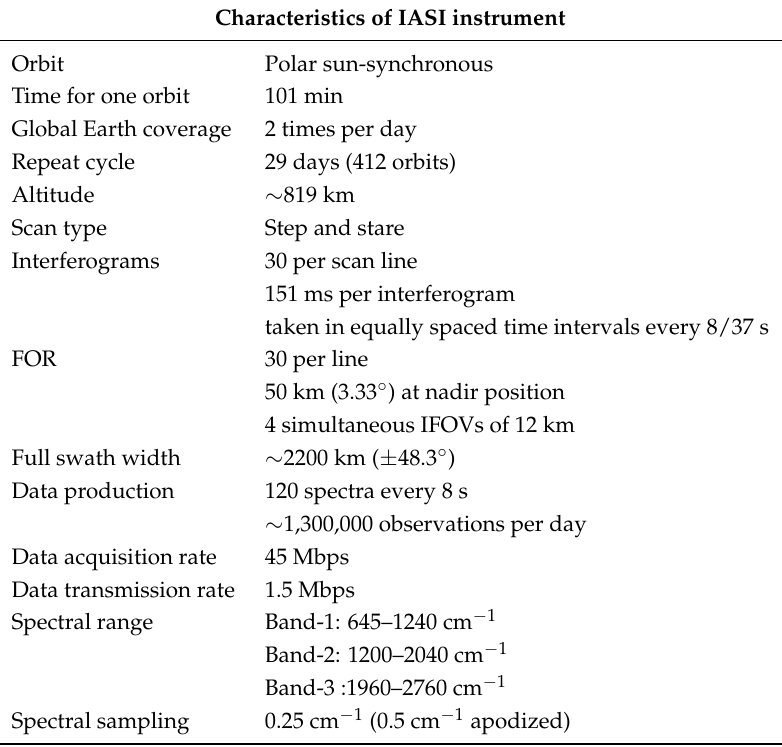
Table 1. Main characteristics of IASI instrument [50].